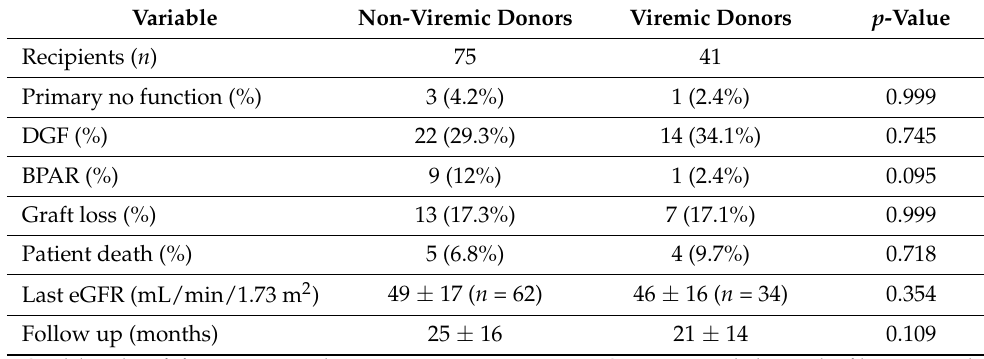
Table 2. Outcome variables from transplants performed with hepatitis C virus positive non-viremic and viremic donors.